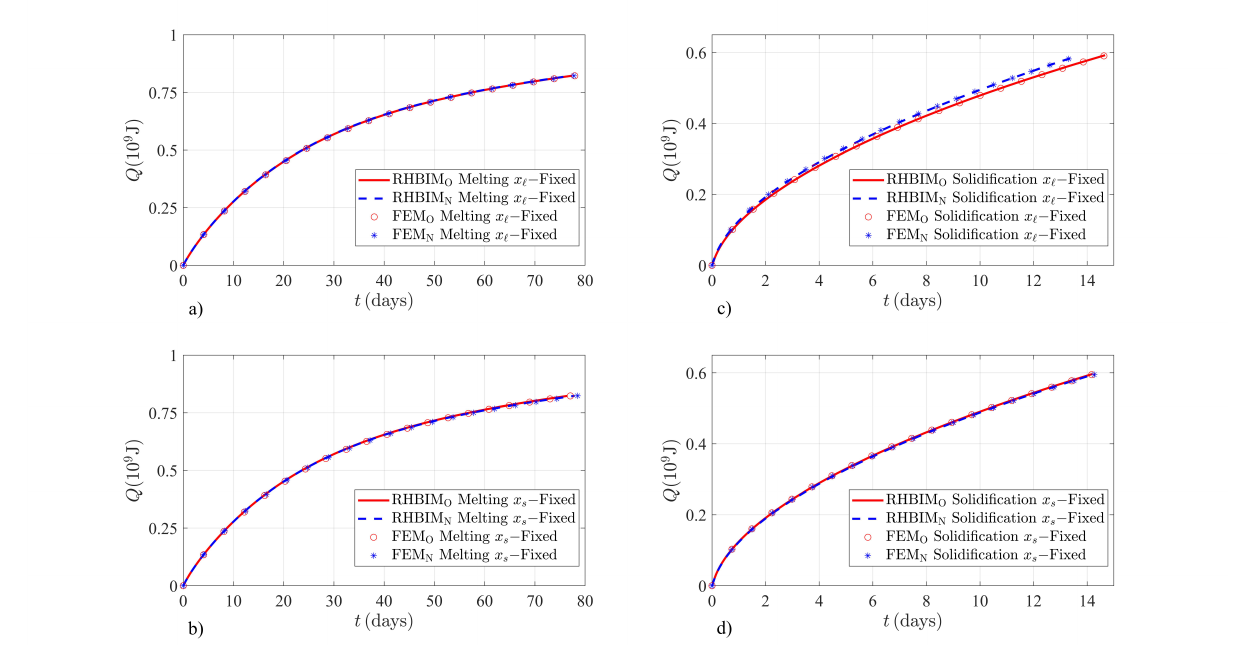
Figure 3. Finite element method and RHBIM solutions to the total energy absorbed and released by the KNO 3 salt. Solutions obtained from the old and new models are shown in each case. ( a ) Time evolution of the energy absorbed Q = h ( t ) − h ( 0 ) in GJ when x (cid:96) ( t ) is constant in time. Solutions corresponding to the old model were obtained from Equations (5a), (6a), and (4), and according to the new model by using the apparent latent heat given by Equation (13a). ( b ) Thermal energy absorbed Q when x s ( t ) is fixed. Solutions from local thermal balance are obtained through Equations (5b), (6b), and (4), and the contributions from total thermal balance were considered through the apparent latent heat given by Equation (13b). ( c ) Energy released Q = h ( 0 ) − h ( t ) during solidification of the liquid phase. Thermal energy released according to the new model is estimated from the solutions obtained through the apparent latent heat given by Equation (15a). ( d ) Thermal energy released when x s ( t ) is fixed in time. Predictions from the solutions according to the new model are obtained through the apparent latent heat given by Equation